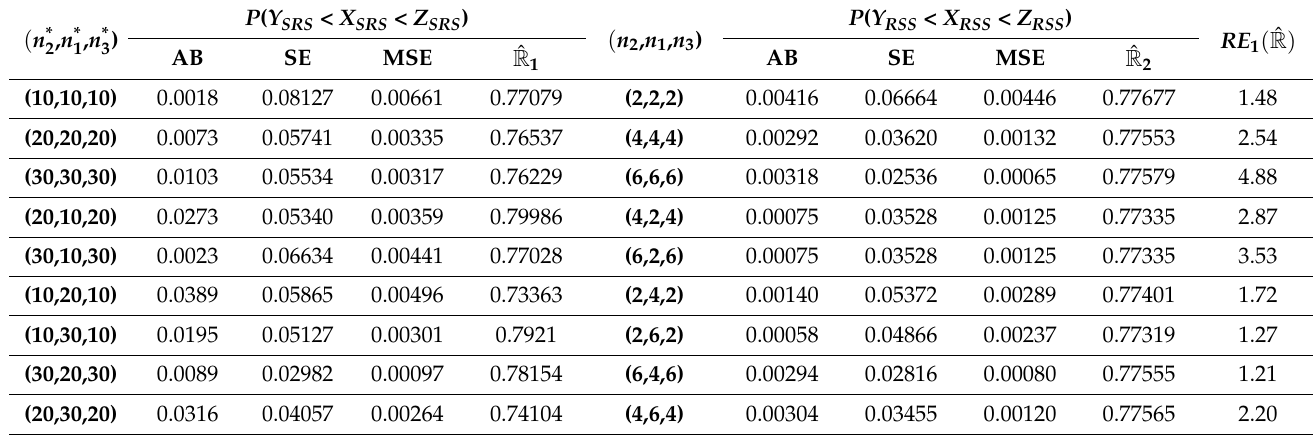
Table 5. Measurements of ˆ R 1 and ˆ R 2 for sampling schemes at R = 0.773 and d =